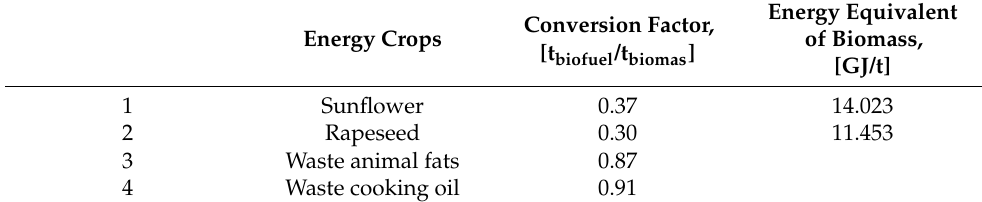
Table 3. Conversion factor for biomass to biodiesel